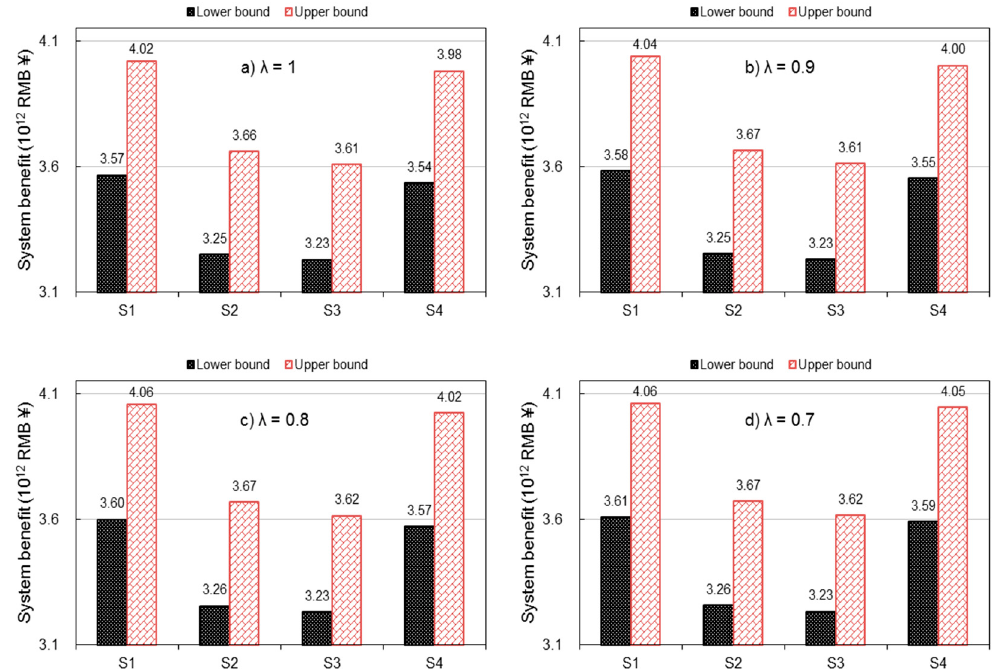
Figure 9. System benefits under different λ levels and scenarios (10 12 RMB¥). Note: λ = 1, 0.9, 0.8, 0.7; S1, Scenario 1; S2, Scenario 2; S3, Scenario 3; S4, Scenario 4.